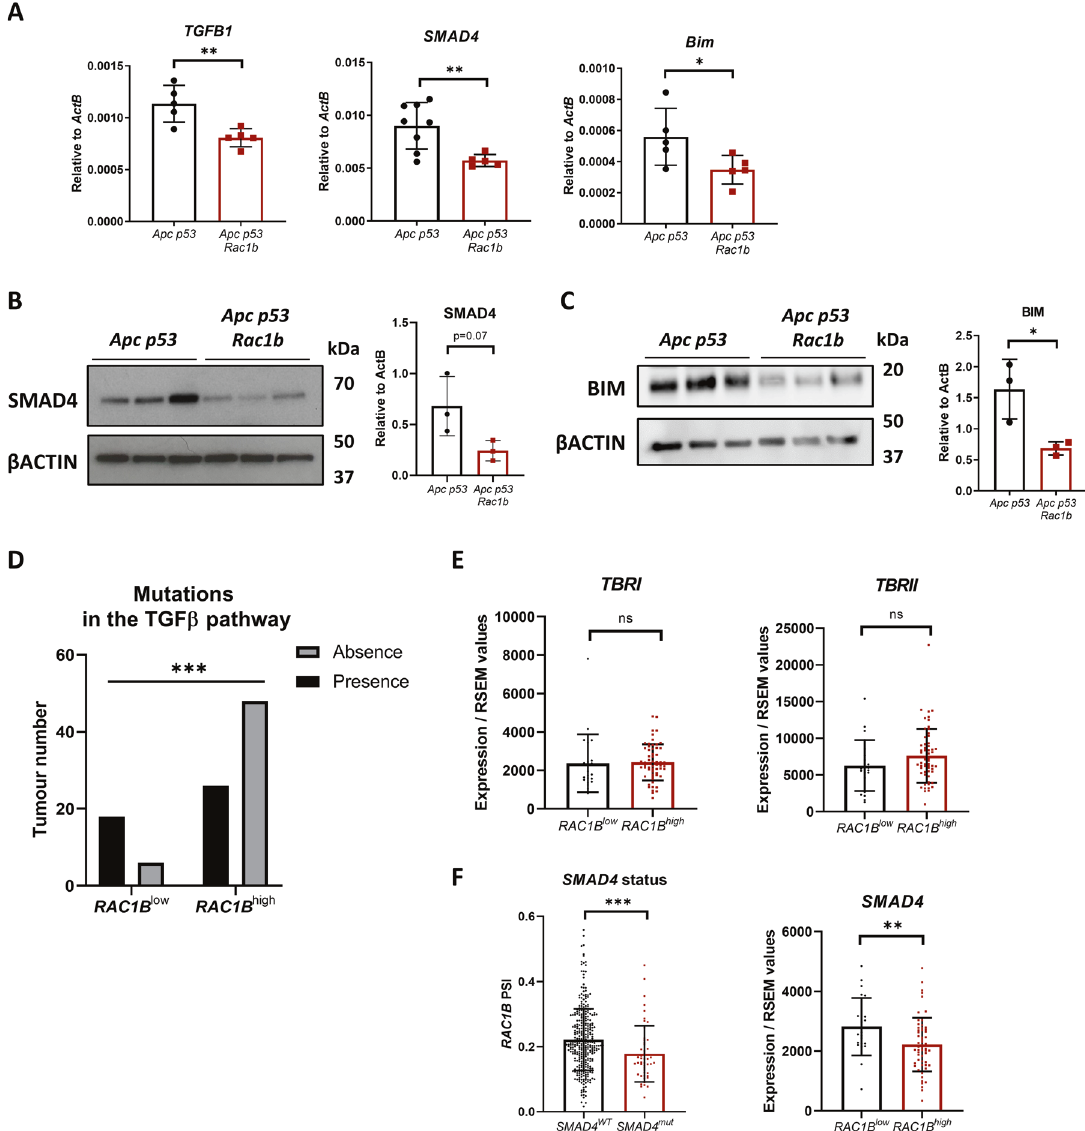
Fig. 6 Negative regulation of TGF β signalling by RAC1B in vivo. A qRT-PCR analysis of TGFB1 , SMAD4 and BIM gene expression of SI from Apc p53 and Apc p53 Rac1b mice after 31 days of tamoxifen induction for gene expression (error bars represent SD; * P < 0.05, ** P < 0.01; two tailed t test, n = 5vs5). B Western blot analysis of day-31 Apc p53 and Apc p53 Rac1b intestinal epithelial extractions protein lysates for SMAD4 and β ACTIN. Graph represents SMAD4 band densitometry quanti fi cation relative to β ACTIN (error bars represent SD; # P < 0.10; two tailed t test, n = 3vs3). C Western blot analysis of day-31 Apc p53 and Apc p53 Rac1b intestinal epithelial extractions protein lysates for BIM and β ACTIN. Graph represents BIM band densitometry quanti fi cation relative to β ACTIN (error bars represent SD; * P < 0.05; two tailed t test, n =